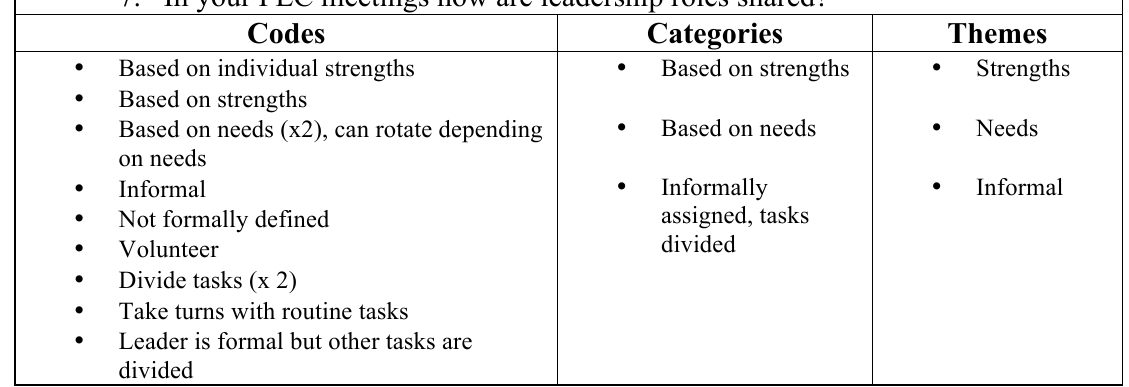
Teacher Question Seven and